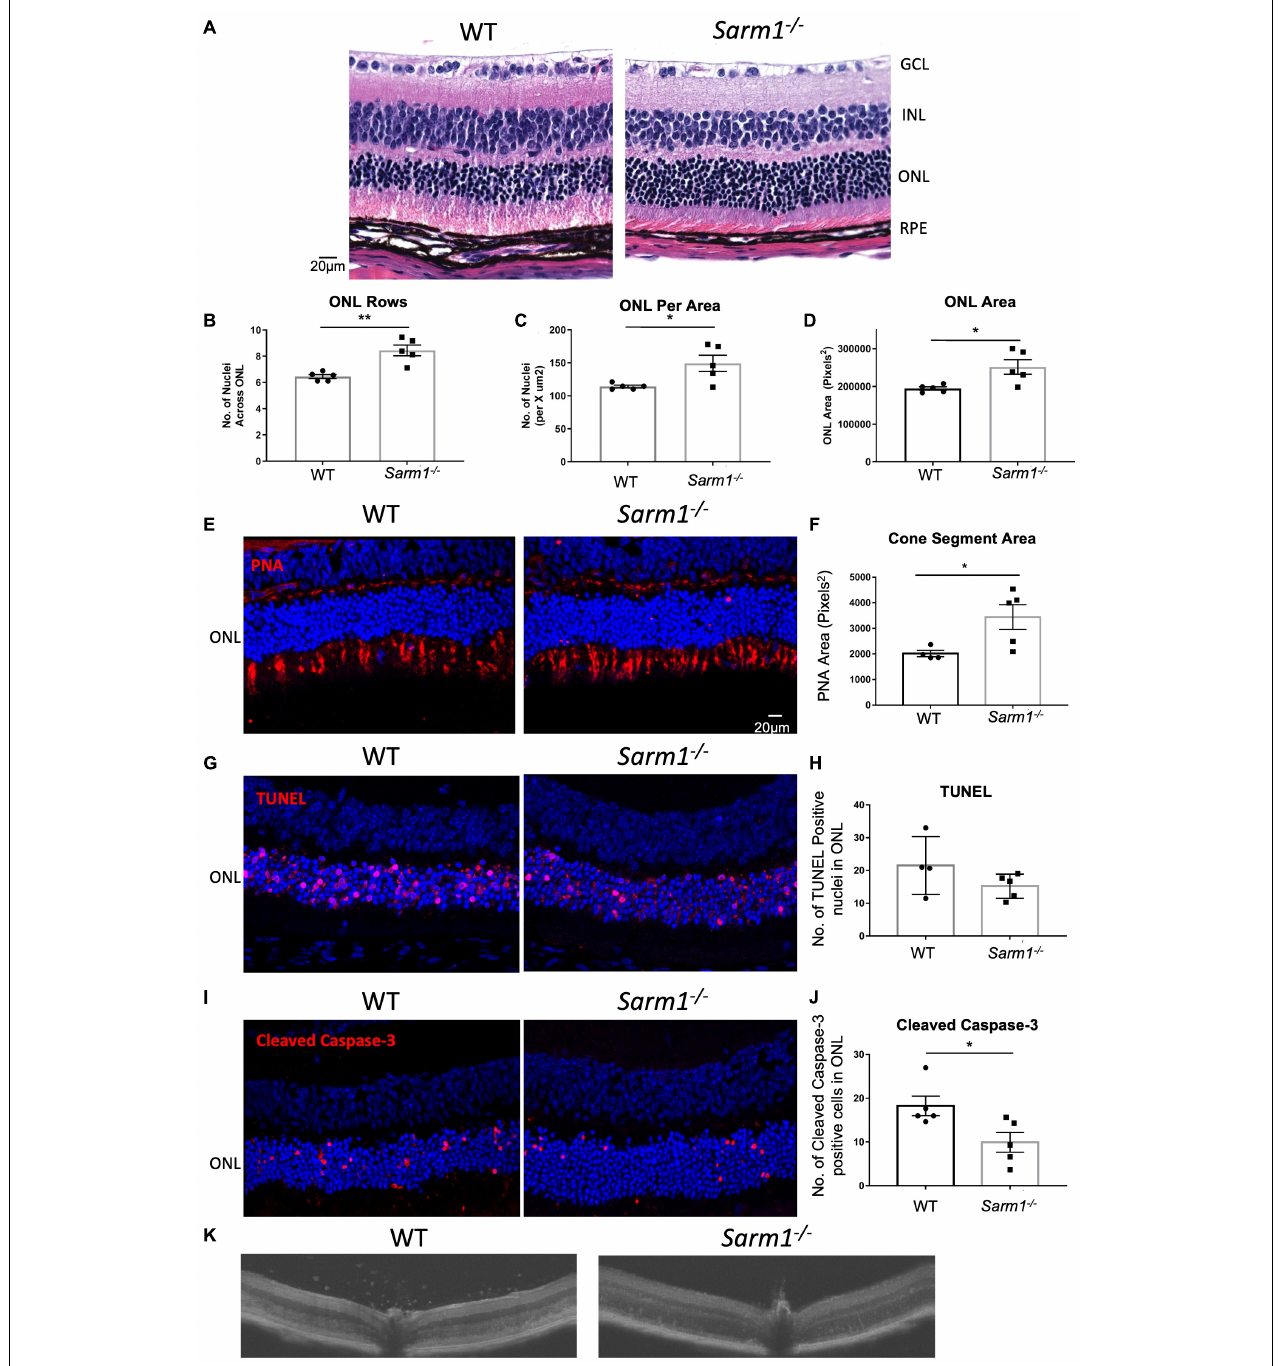
FIGURE 2 | SARM1 promotes photoreceptor cell death in the NaIO 3 model of retinal degeneration. Representative images of paraffin embedded retinal sections from WT and Sarm1 − / − mice 3-days post administration of NaIO 3 stained with haematoxylin and eosin (H&E) (A) . Quantification of the number of nuclei per ONL row (B) , number of nuclei in the ONL in an area of height 450 pixels in the centre of the ONL in each image (C) , and ONL area (* P ≤ 0.05, ** P ≤ 0.01, n = 5 mice) (D) . Representative images of retinal cryosections stained with PNA (E) . Quantification of area of PNA stained cone segments (* P ≤ 0.05, n = 4 WT mice, n = 5 Sarm1 − / − mice) (F) . Representative images of paraffin embedded retinal sections from WT and Sarm1 − / − mice 3-days post administration of NaIO 3 stained with TUNEL (Red) and DAPI (Blue) (G) . Quantification of the number of TUNEL positive nuclei in the ONL ( n = 4 WT mice, n = 5 Sarm1 − / − mice) (H) . Representative images of retinal cryosections from WT and Sarm1 − / − mice 3-days post administration of NaIO 3 stained with cleaved caspase-3 (Red) and DAPI (Blue) (I) . Quantification of the number of cleaved caspase-3 positive cells in the ONL (* P ≤ 0.05, n = 4 WT mice, n = 5 Sarm1 − / − mice) (J) . Optical coherence tomography (OCT) images taken in vivo from C57BL/6J and Sarm1 − / − mice 3-days post administration of NaIO 3 (50 mg/kg) (K) .